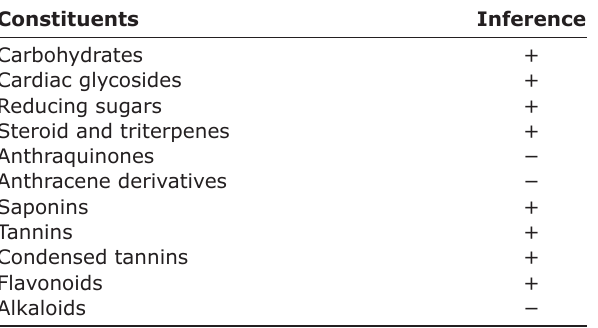
Table-1: Phytochemical constituents of the methanol leaf extract of Ficus exasperate. Constituents